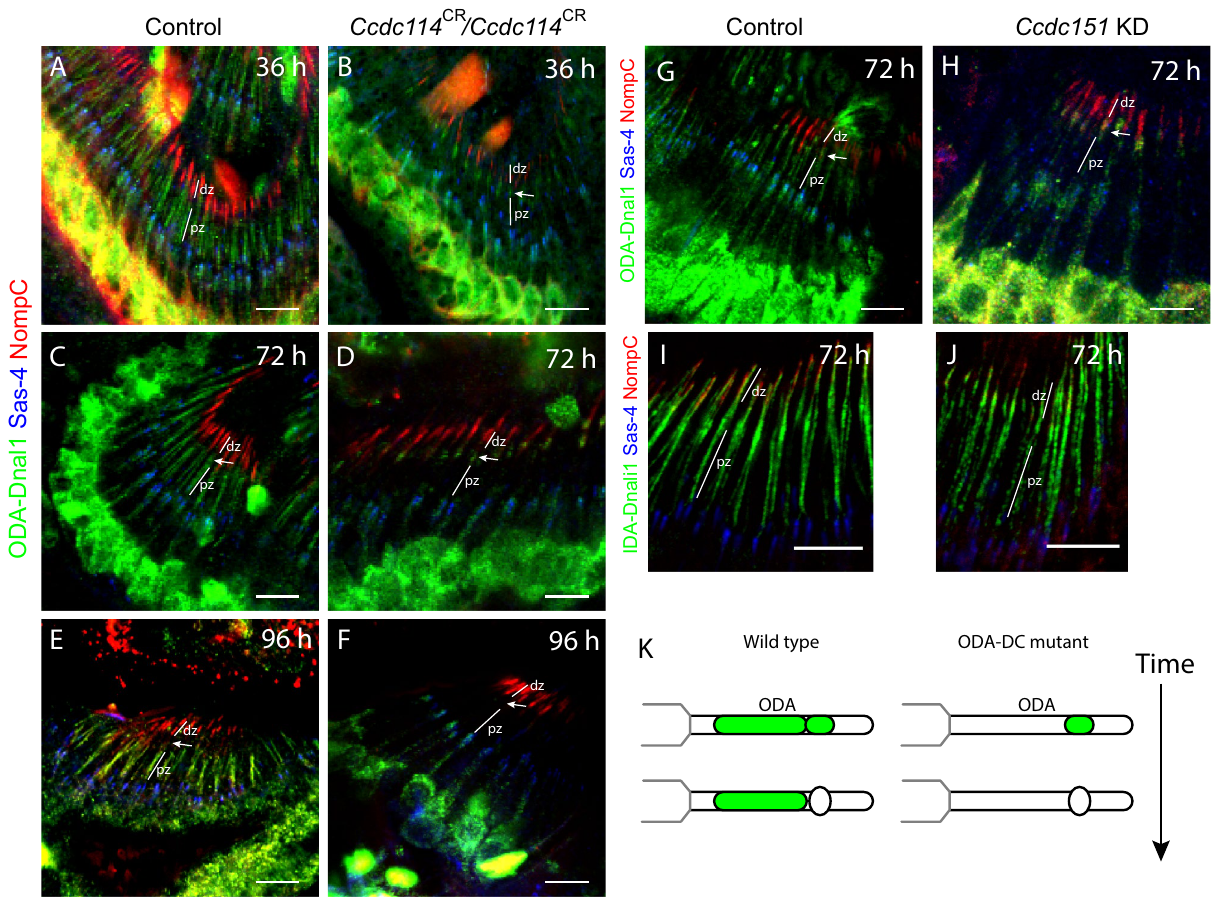
Figure 6. Loss of stable ODA localisation in ODA-DC mutants. ( A – F ) Localisation of ODA-Dnal1 to the proximal zone is abolished in Ccdc114 homozygotes ( B , D , F ) compared with heterozygote controls ( A , C , E ) in pupal antennae of the timepoints indicated (with proximal zones (pz) and distal zones (dz) indicated). ODA- Dnal1 (green), Sas-4 (blue), NompC (red). At 36 and 72 h, expression is absent from the proximal zone but remains in the ciliary dilation (arrow). At 96 h, all expression is absent. ( G , H ) Localisation of ODA-Dnal1 to the proximal zone is strongly reduced in knockdown of Ccdc151 ( scaGal4 , UAS- Ccdc151 -RNAi) ( G ) compared with control ( scaGal4 , KK line control) ( H ). As for Ccdc114 , expression remains in the ciliary dilation (arrow). ODA-Dnal1 (green), Sas-4 (blue), NompC (red). In contrast, localisation of IDA-Dnali1 to cilia is unaffected in knockdown of Ccdc151 . IDA-Dnali1 (green), Sas-4 (blue), NompC (red). ( K ) Schematic summary. All scale bars are 5